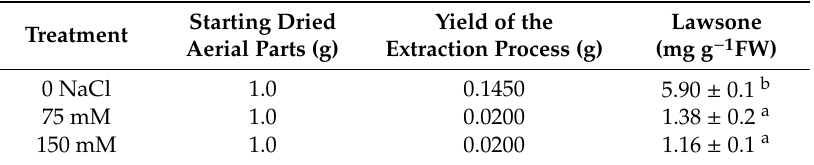
Table 3. Results of the lawsone extraction process and its quantitative analyses in Lawsonia inermis aerial parts subjected to control (0 NaCl) and saline treatments (75 and 150 mM NaCl). Data are presented as means ± SD ( n = 3). Di ff erent letters indicate statistically significant di ff erences with Fisher’s probable least-squares di ff erence test ( p ≤